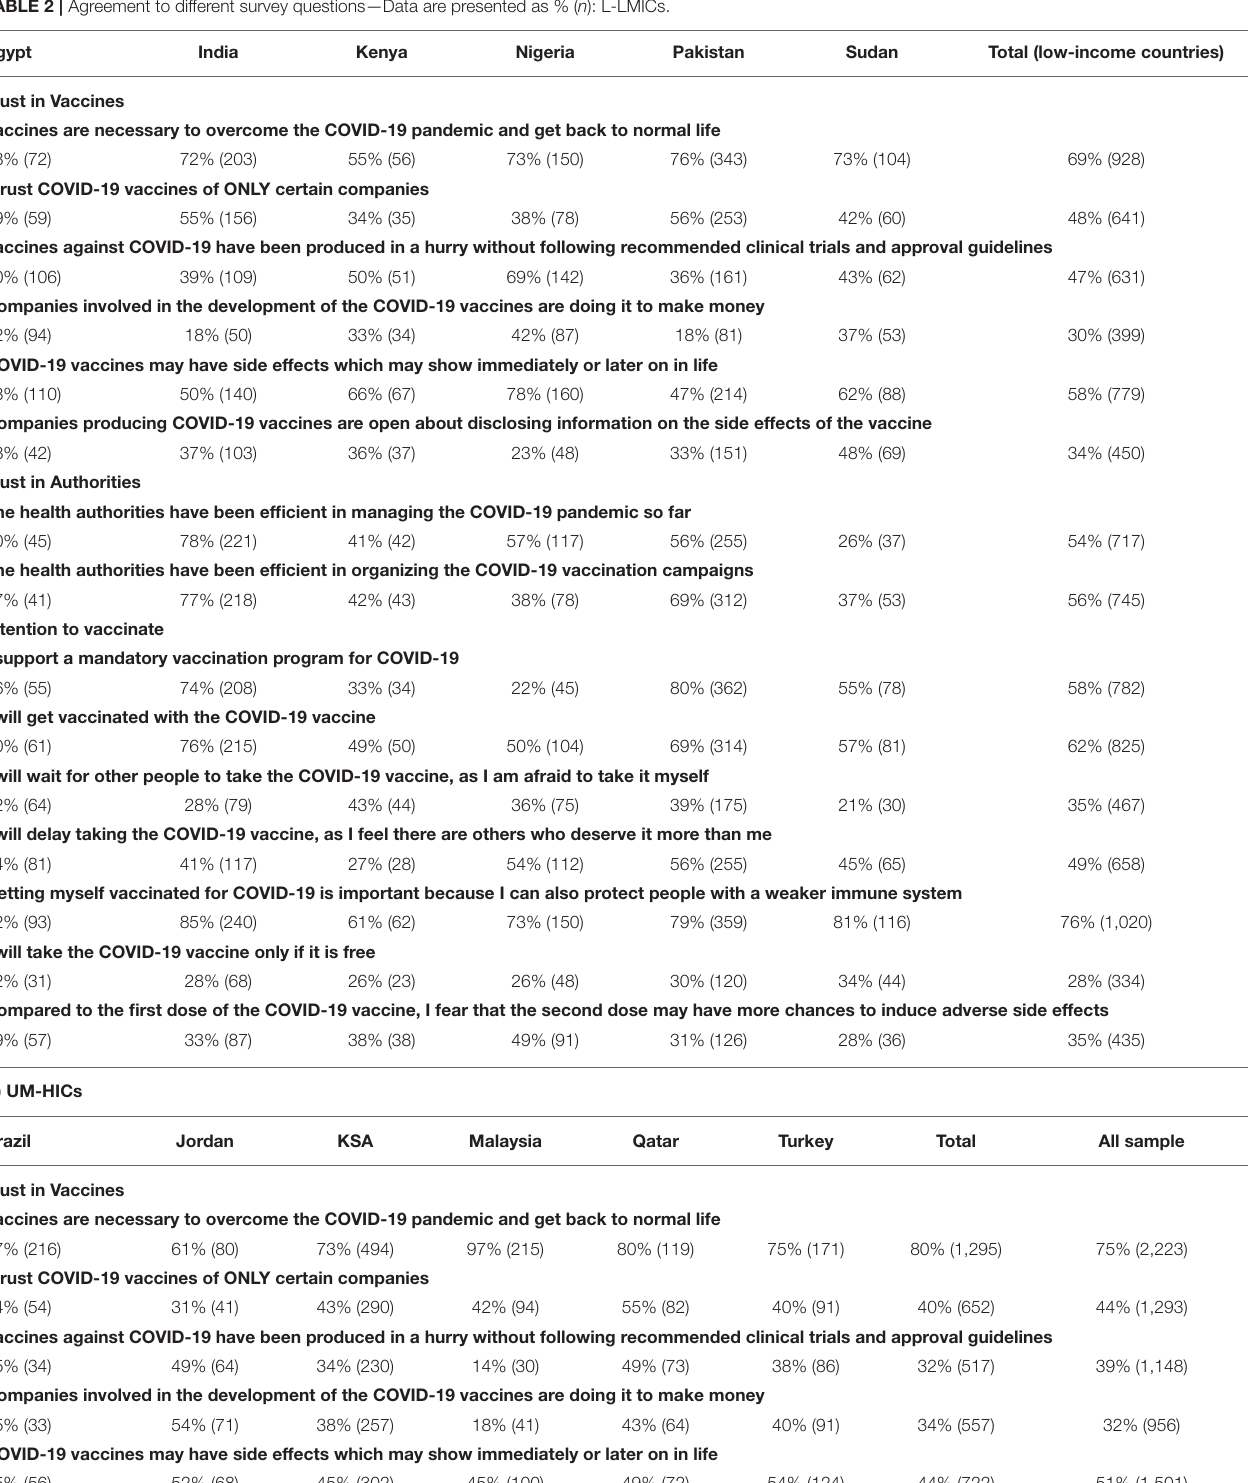
TABLE 2 | Agreement to different survey questions—Data are presented as % ( n ): L-LMICs. Egypt India Kenya Nigeria Sudan Total (low-income